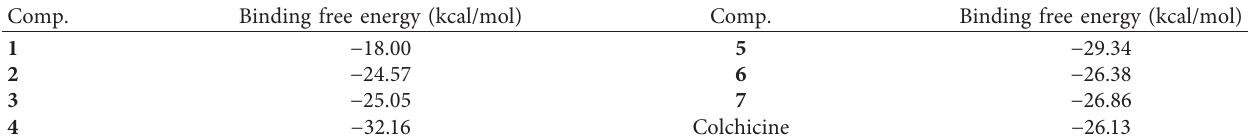
Table 1: The docking scores of the synthesized compounds, colchicine, and colchicine against tubulin receptor. Comp.